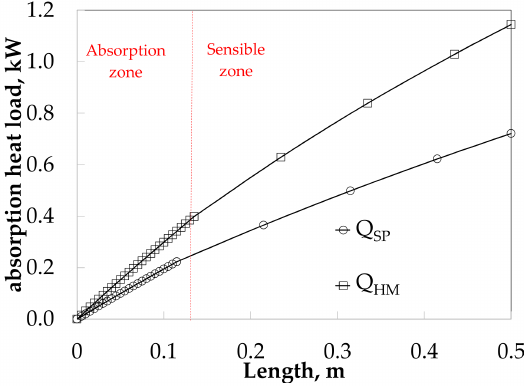
Figure 13. Absorber heat load along the absorber for SP and